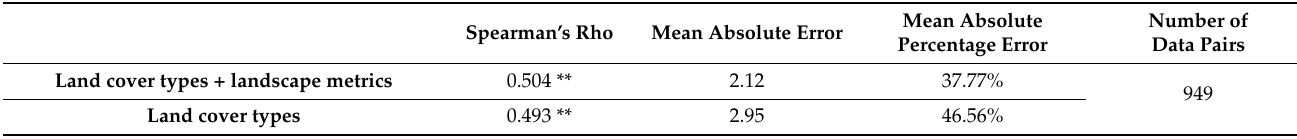
Table 4. Summary table of the correlation and error indices, which show the accuracy of the predicted values, based on land cover types and land cover types + landscape indices.